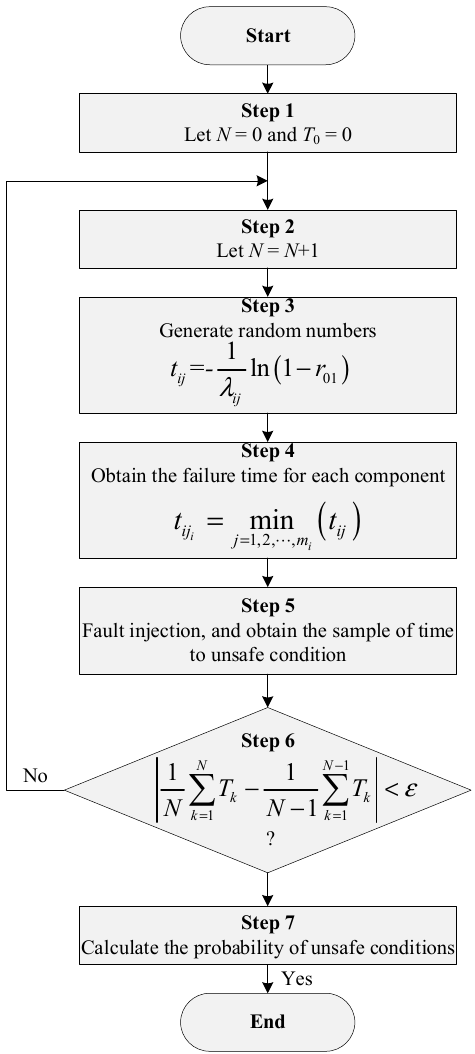
Figure 7. Flowchart of the Monte Carlo simulation.